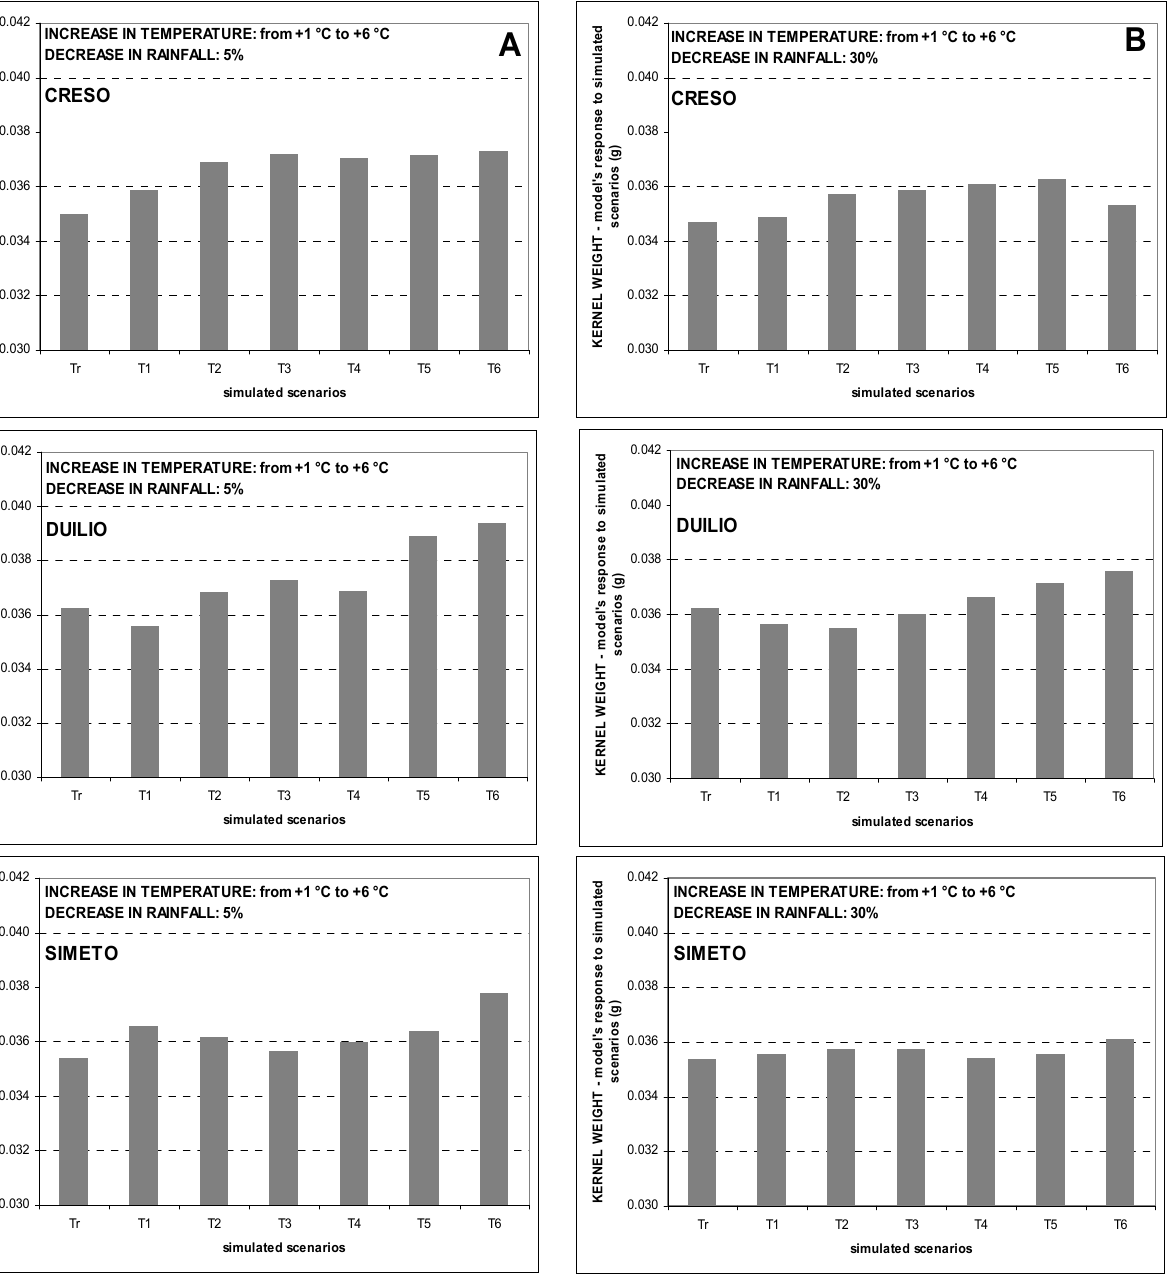
Figure 6. Average seed weight trends over the period 1990–2004 at the experimental site of Benatzu for climate change scenarios characterized by increasing temperature (from +1 °C to +6 °C) and rainfall reduction by 5% ( A ) and 30% ( B ). Tr = observed data.